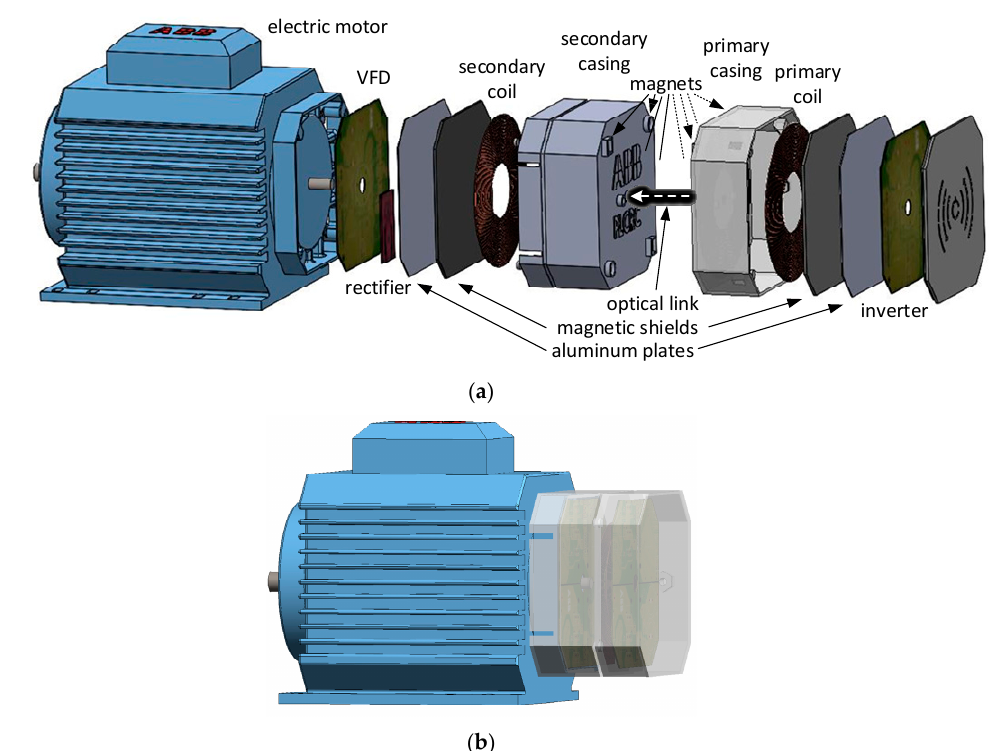
Figure 1. Visualization of IPT-IMD system: ( a ) disassembled, ( b ) assembled.